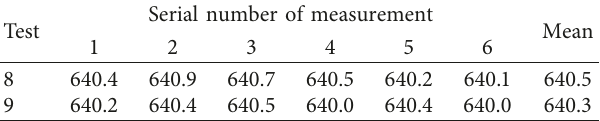
Table 3: Integral voltages of specimens with duct and grout (unit: